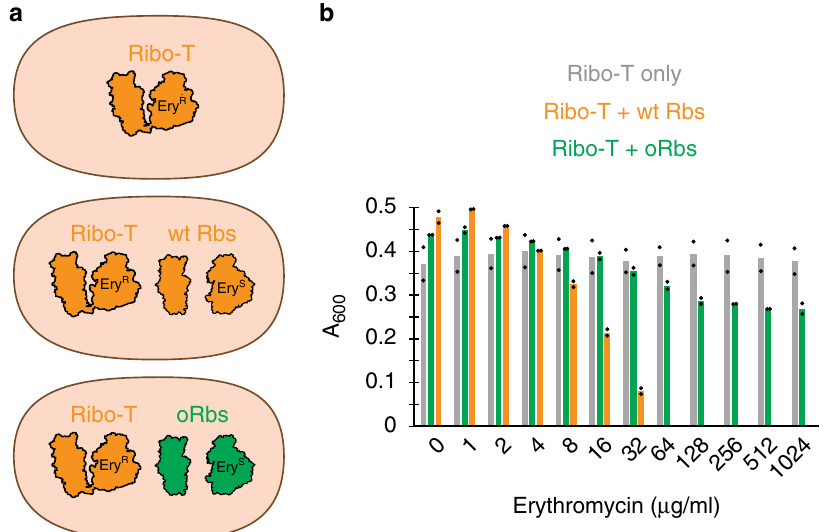
Fig. 4 Resistance of the OSYRIS cells to erythromycin (Ery) illustrates the functional isolation of the orthogonal dissociable ribosome. a Ribosome composition of the OSYRIS cells expressing (orange) (wt Rbs)or orthogonal (green) (oRbs) ribosomes. Tethered ribosomes carry the A2058G mutation rendering them resistant to Ery (Ery R ), whereas dissociable ribosomes are sensitive to Ery (Ery S ). b Optical density ( A 600 ) of the OSYRIS cells cultures expressing wt Rbs or oRbs after 24 h growth in the 96-well plates in the presence of the indicated concentrations of Ery. Expressing Ery S wt Rbs alongside Ery R Ribo-T renders cells sensitive to Ery (orange bars) supporting the involvement of the 50S subunit upon its association wityh wt 30S subunit in proteome translation (MIC Ery of these cells is 64 µ g/mL). In contrast, cells expressing oRbs remain Ery R , demonstrating that the 50S subunit of the oRbs in the OSYRIS cells is functionally isolated and does not participate in the translation of the cellular proteome. The bar graph represents the mean of two biological replicates with individual data points indicated by black dots. The raw data can be found in the Source data fi highest tested concentration of the antibiotic (1 mg/ml) (Fig. 4, functionally dedicated to each other in spite of the lack of a green bars), demonstrating the functional autonomy of the dis- physical linkage between them. sociable 50S subunit and Ribo-T. In contrast, expression of the o- GFP reporter progressively decreased with the increase of Ery concentration in the medium (Fig. 5a). This result indicates that translation of the o-reporter is driven primarily by the ribosome composed of dissociable o-30S and 50S subunits, as opposed to o- 30S/Ribo-T hybrids (Fig. 5a). Thus neither o-30S subunit, not 50S subunit interact with Ribo-T and both subunits remain